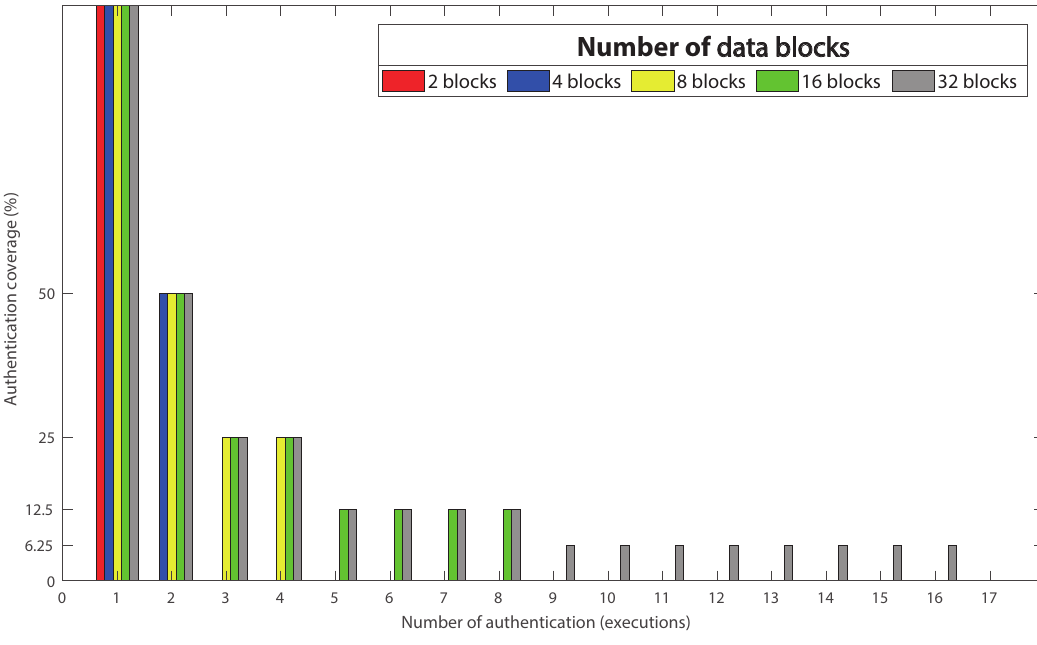
Figure 2. Authentication coverage for data by the number of